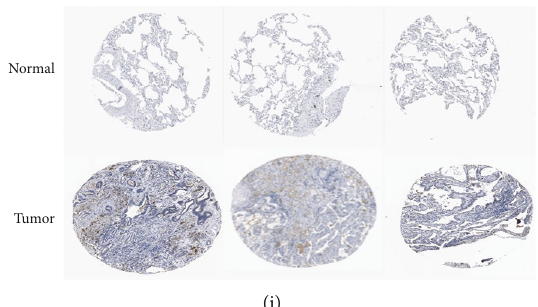
Figure 1: SLC2A5 is highly expressed in LUAD. (a) The expression level of SLC2A5 in di ff erent types of tumor tissues and normal tissues in the Oncomine database. ( P value is 0.05, data type is mRNA, and gene ranking of all.) (b) The expression level of SLC2A5 in di ff erent types of tumor tissues and normal tissues in the TIMER database ( ∗ P < 0 : 05 , ∗∗ P < 0 : 01 , and ∗∗∗ P < 0 : 001 ). (c – f) The expression of SLC2A5 in LUAD is higher than that in normal tissues in di ff erent databases (SLC2A5 expression in Su ’ s dataset, Hou ’ s dataset, Stearman ’ s dataset, and Okayama ’ s dataset) in Oncomine. (g) High expression of SLC2A5 mRNA in LUAD tissues ( n = 483 ) compared with the normal tissues ( n = 347 ) in the GEPIA database. (h) High protein expression of SLC2A5 in LUAD tissues ( n = 111 ) compared with the normal tissues ( n = 111 ) in the UALCAN database. (i) Immunohistochemistry (IHC) of SLC2A5 expression in LUAD tissues and corresponding normal tissues based on